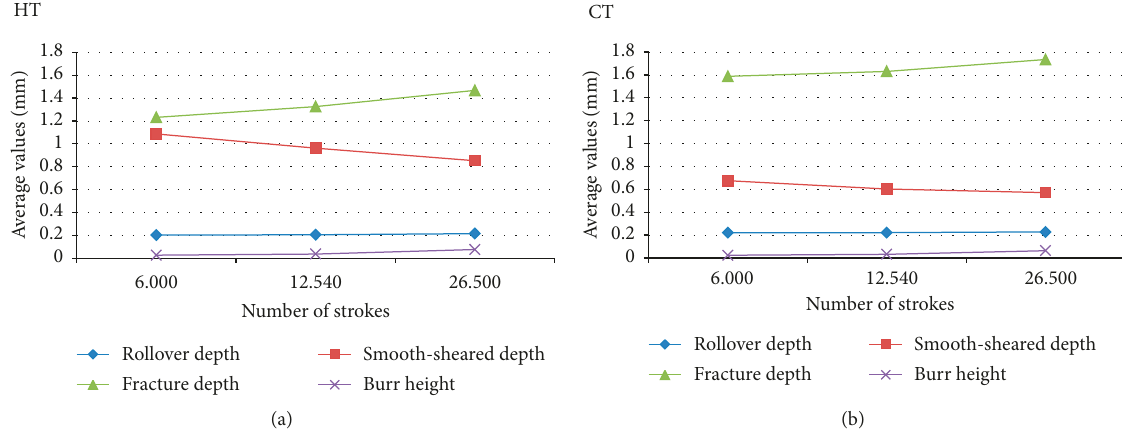
Figure 13: Average values of geometry of the cut surface of the holes of the control arm part (slot hole 10.5 × 8.5mm in size).